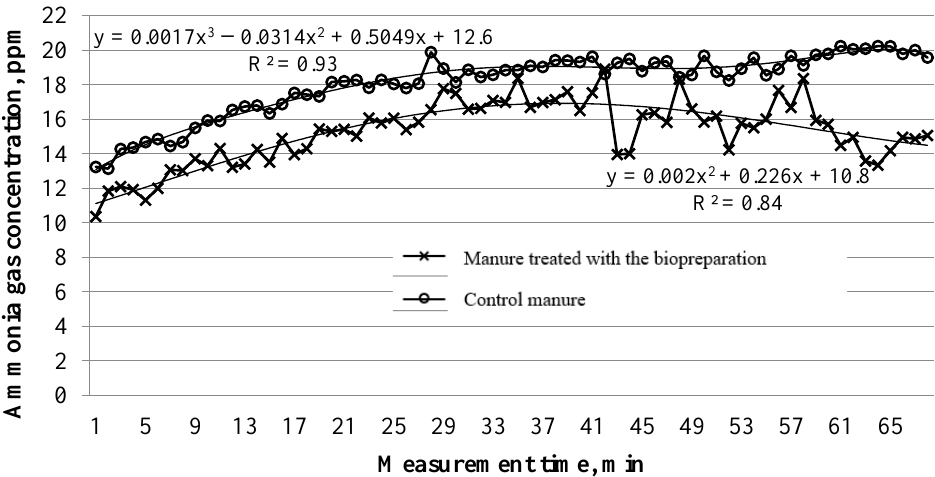
Figure 4. Change in ammonia concentration in the wind tunnel with the addition of the manure treated with the biopreparation and the control manure without additives (10 days after the addition of the biopreparation by mixing the manure).